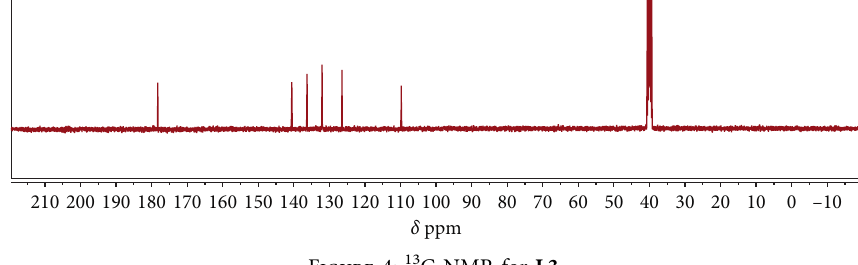
Figure 4: 13 C-NMR for L3